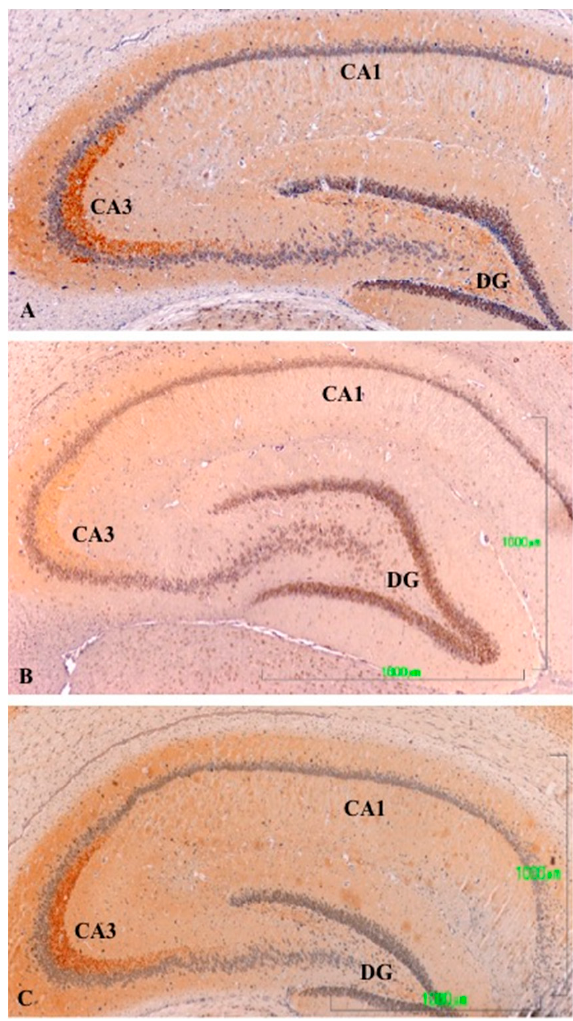
Figure 3. ( A – C ). Tyrosine hydroxylase immunoreactivity in the hippocampus of rats from the control ( A ), paroxetine ( B ), and agomelatine ( C ) groups. Bars, 1000 m. (Figure 3A is presented at the